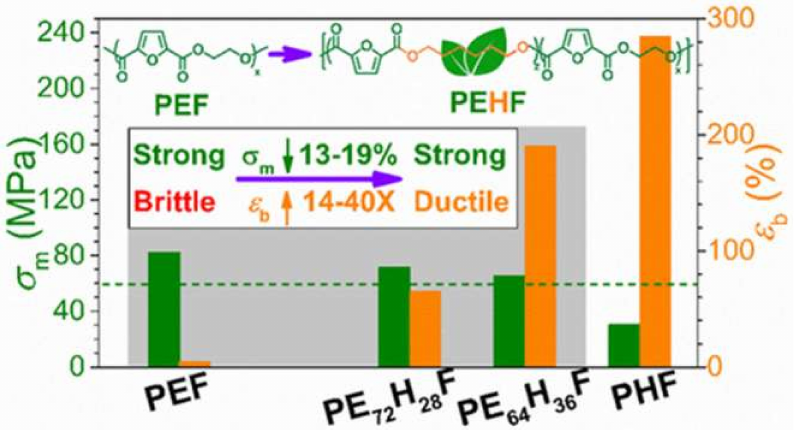
Figure 13. E ff ect of hexylene 2,5-furan dicarboxylate content on the mechanical properties of PEHF copolymers